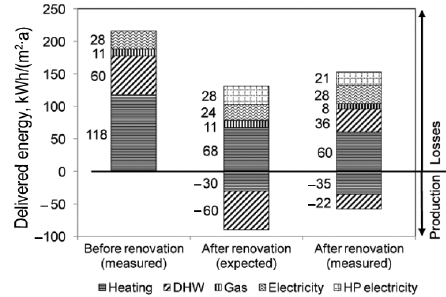
Fig. 4. Energy performance before and after renovation